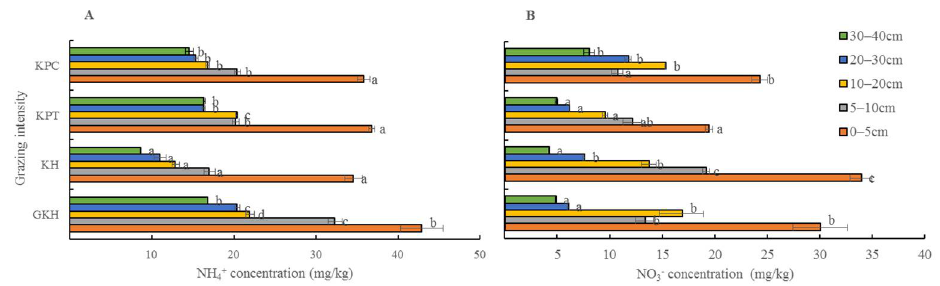
soil layers at different grazing intensities: GKH (3.75 ± 0.75 sheep/ha), KH (7.25 ± 0.25 270 sheep/ha), KPT (8.50 ± 0.35 sheep/ha), and KPC (11.75 ± 0.95 sheep/ha). Notations: different letters indicate significant differences between pastures ( α = 0.05).